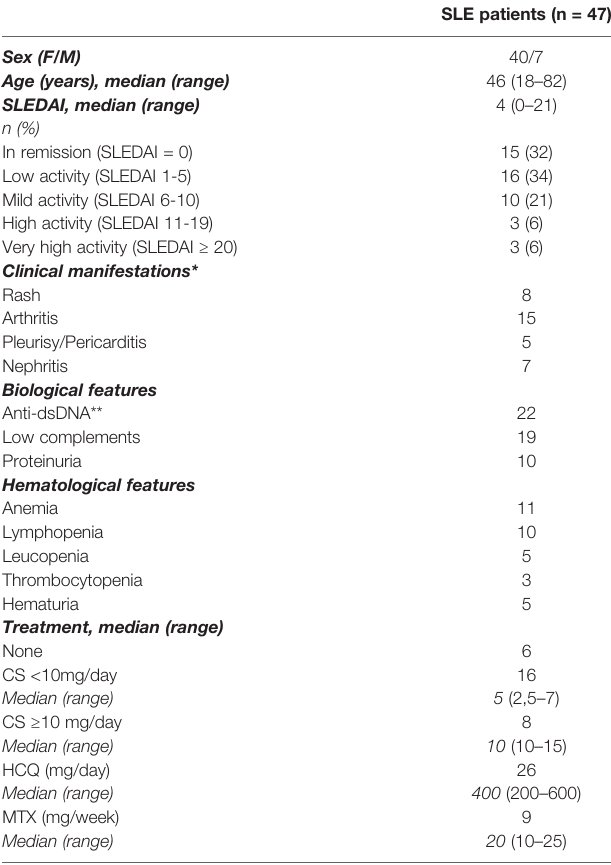
TABLE 1 | Clinical and biological characteristics of SLE